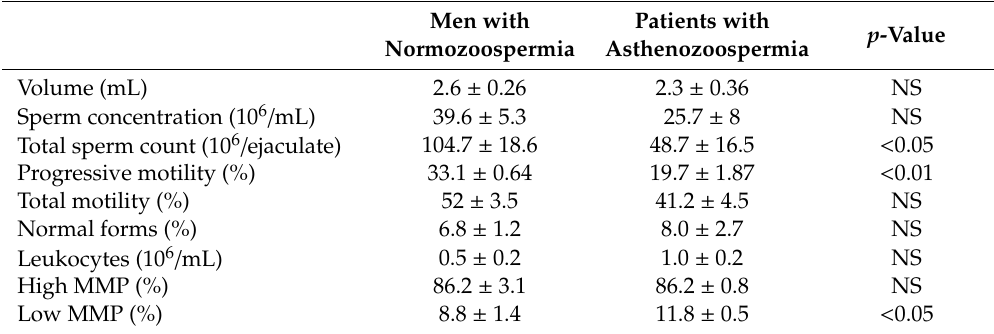
Table 1. Conventional sperm parameters and percentage of spermatozoa with high or low mitochondrial membrane potential (MMP) in men with normozoospermia and patients with asthenozoospermia enrolled in the in vitro part of the present study. Men with Patients with p - Normozoospermia asthenozoospermia Value